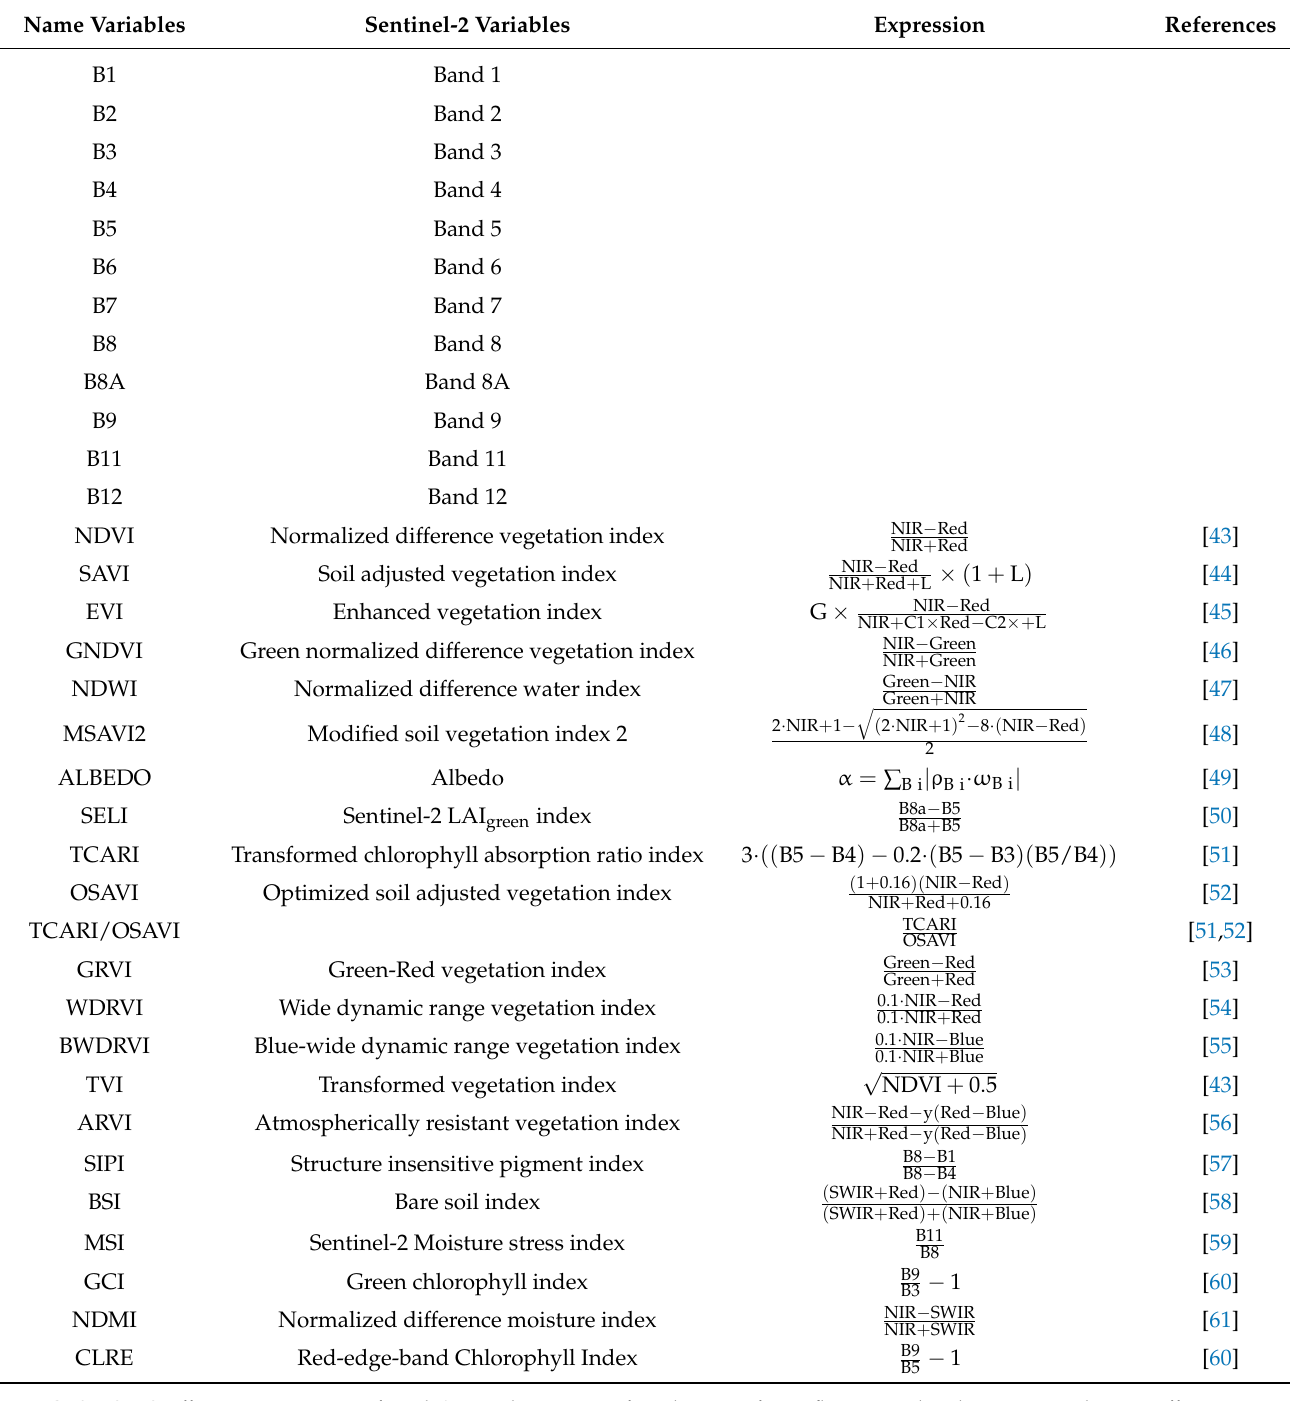
Table 2. Set of sentinel bands and indexes tested for LST